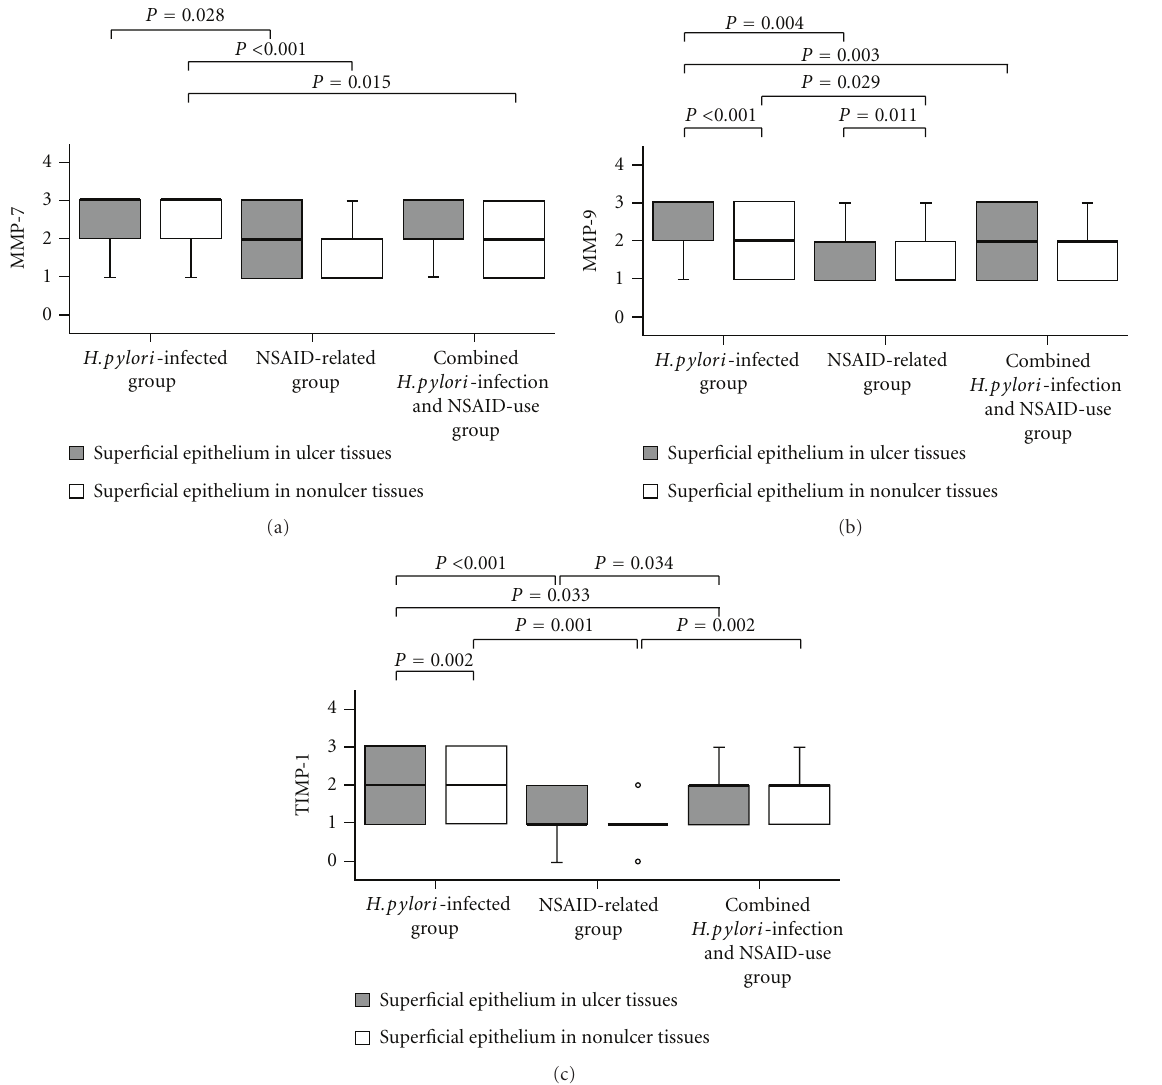
Figure 2: Box plots of the distributions and median scores of MMP-7, and -9 and TIMP-1 in the superficial epithelium of gastric ulcer tissues and nonulcer tissues in di ff erent groups, respectively. The P values compared scores according to patients in the H. pylori -infected, NSAID-related, and combined H. pylori -infection and NSAID-use groups by Mann-Whitney U test, and also compared scores according to ulcer tissues and nonulcer tissues by Wilcoxon signed-rank test. In the box plots, the 75th and 25th percentiles are represented by the top and bottom of the box, respectively. The horizontal lines refer to the medians. Abbreviations are as in Figure